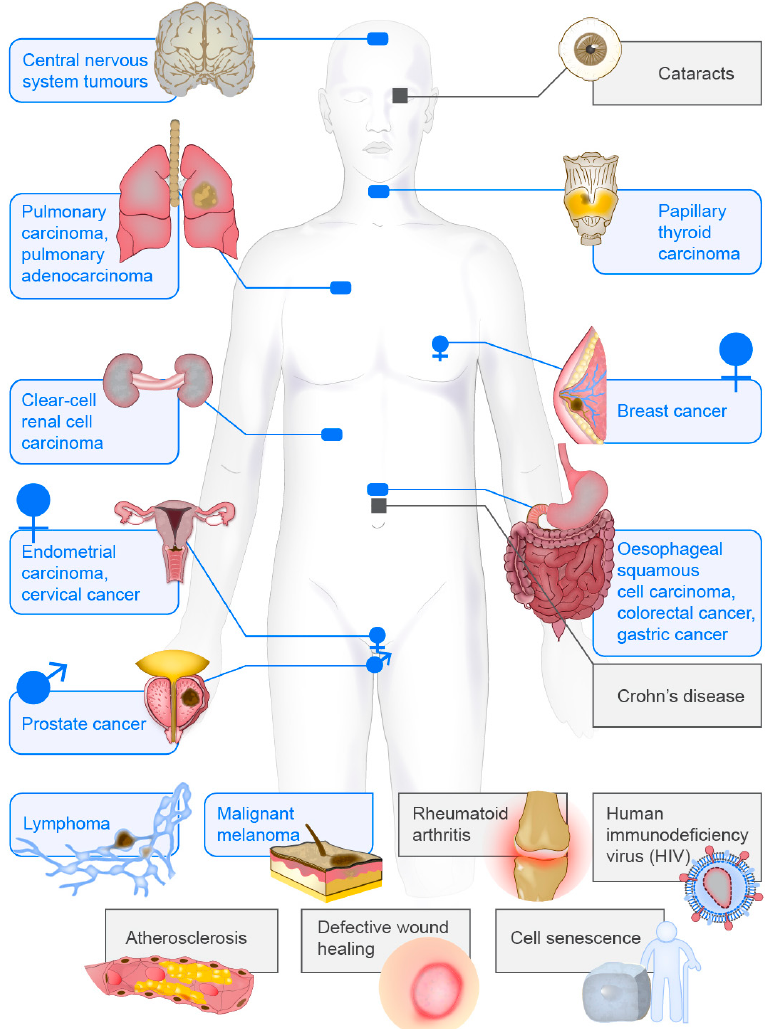
Figure 4. Diseases linked to defective functions of the vimentin protein. Neoplasms are shown in blue boxes, other pathologies in grey boxes.